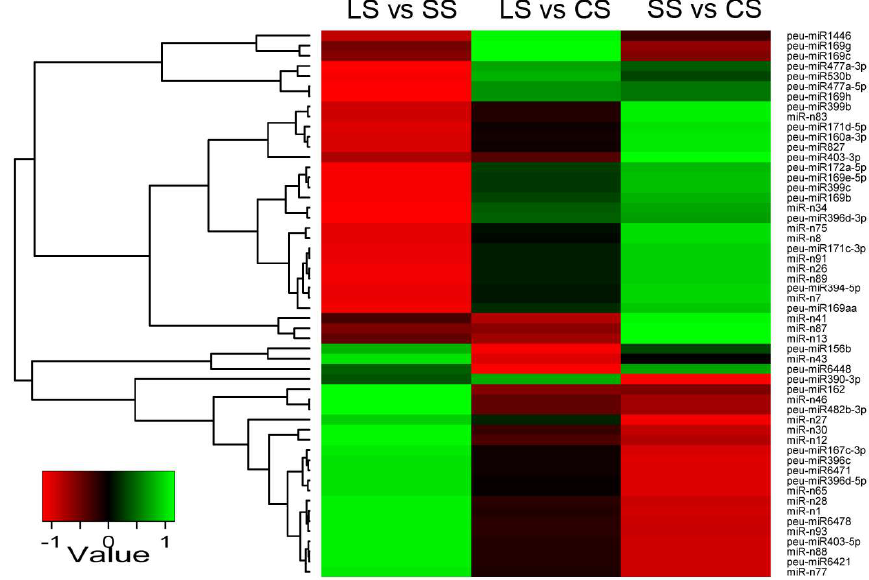
Figure 5. Hierarchical clustering analysis of differentially expressed miRNA in response to ABA in the stems of P. euphratica . The expression profiles were analyzed by Genesis software (http://genome.tugraz.at/) with hierarchical clustering method based on the transcripts per million (TPM) Log 2 FoldChange of miRNAs.